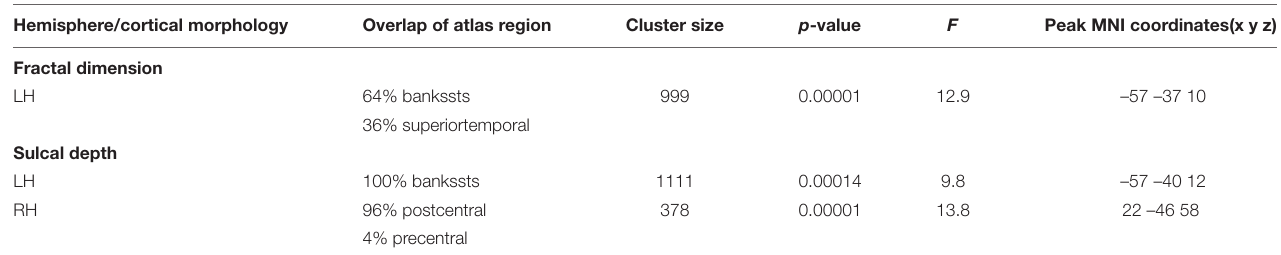
TABLE 2 | Overview of bilateral areas of cluster-level significant effects of cortical characteristics (FWE-corrected). Hemisphere/cortical morphology Overlap of atlas region Cluster size Fractal dimension